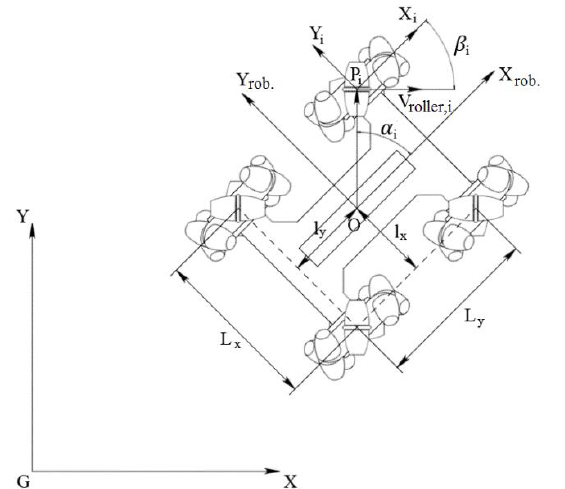
Fig. 5. Mobile robot parameters at any